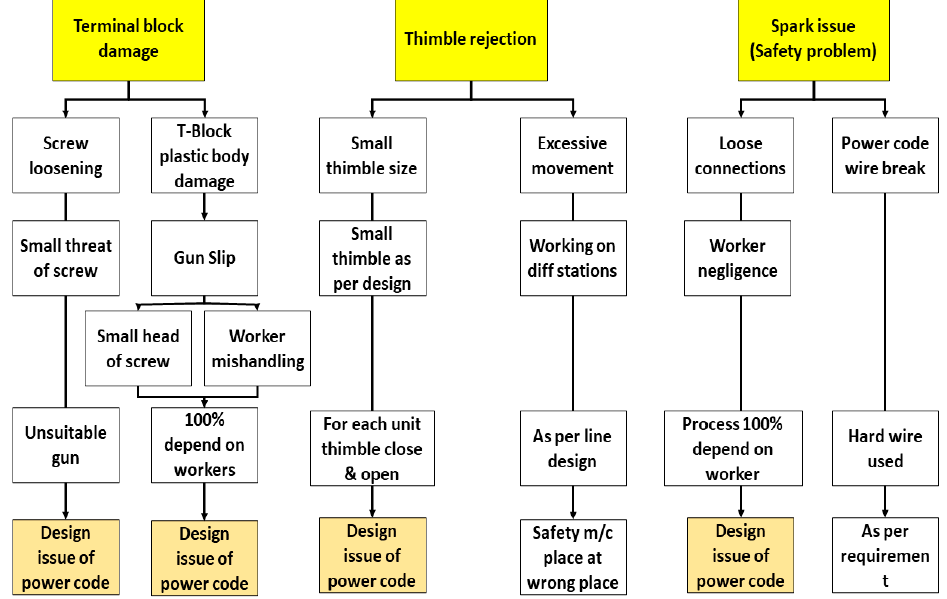
Figure 7. The 5- Why analysis for power cord process. Figure 7. The 5-Why analysis for power cord